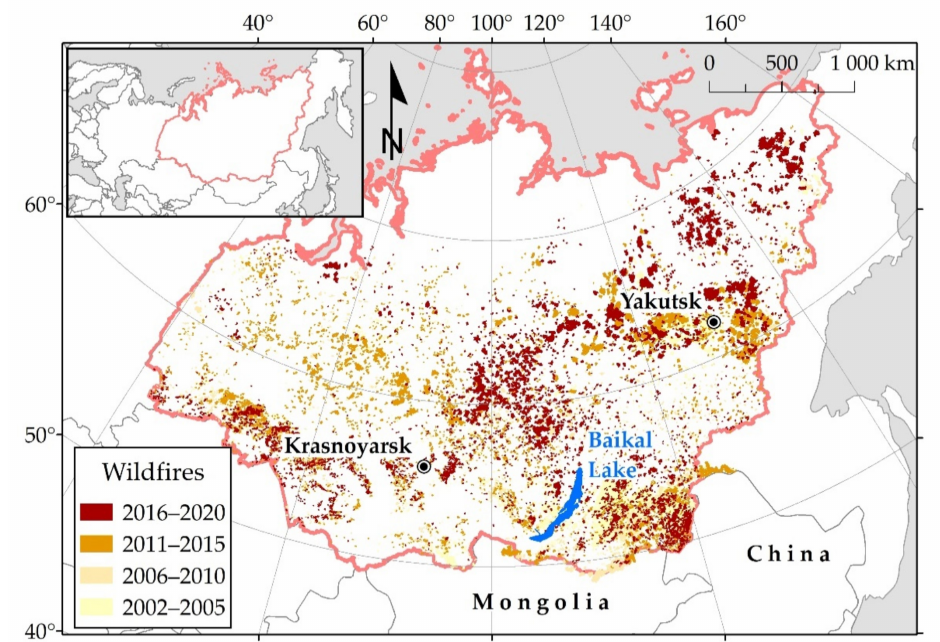
Figure 2. Spatial distribution of wildfires in 2002–2020. Only burned areas >2500 ha are